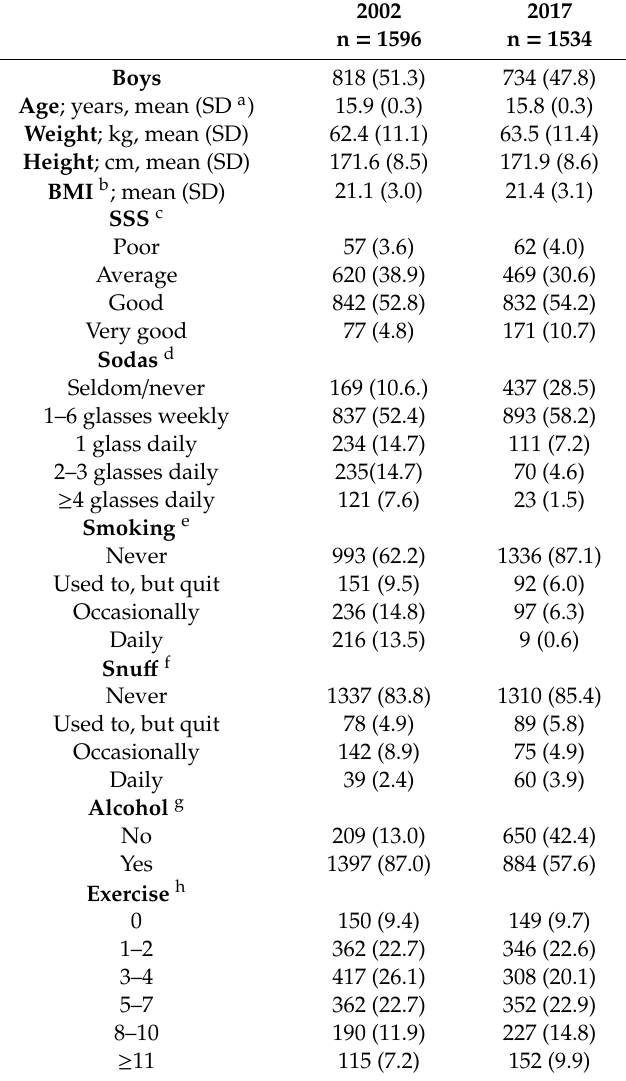
Table 1. Characteristics of tenth-grade students (15–16yearold) in lower secondary schools in the district of Oppland,